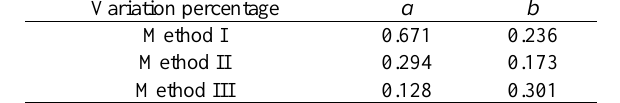
Table 9. Variation percentage of a and b coefficients in the three methods